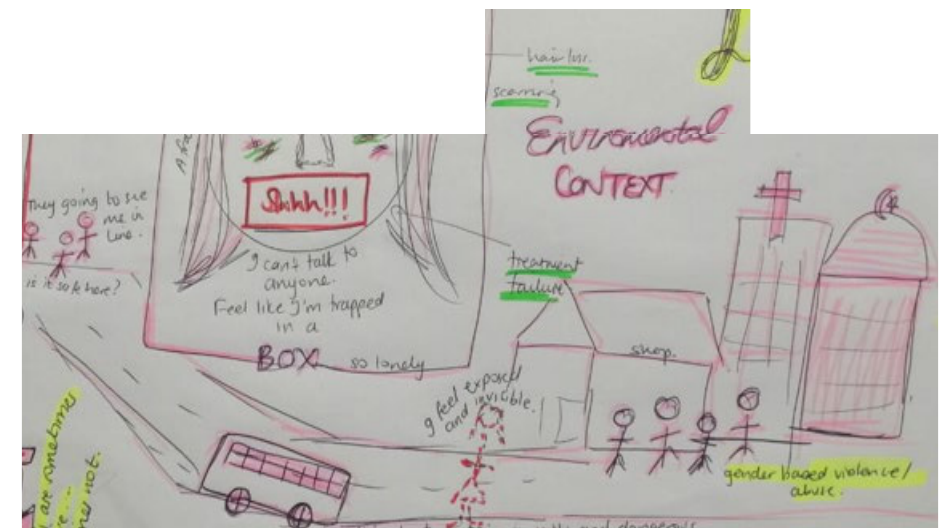
Figure 16. Community places and